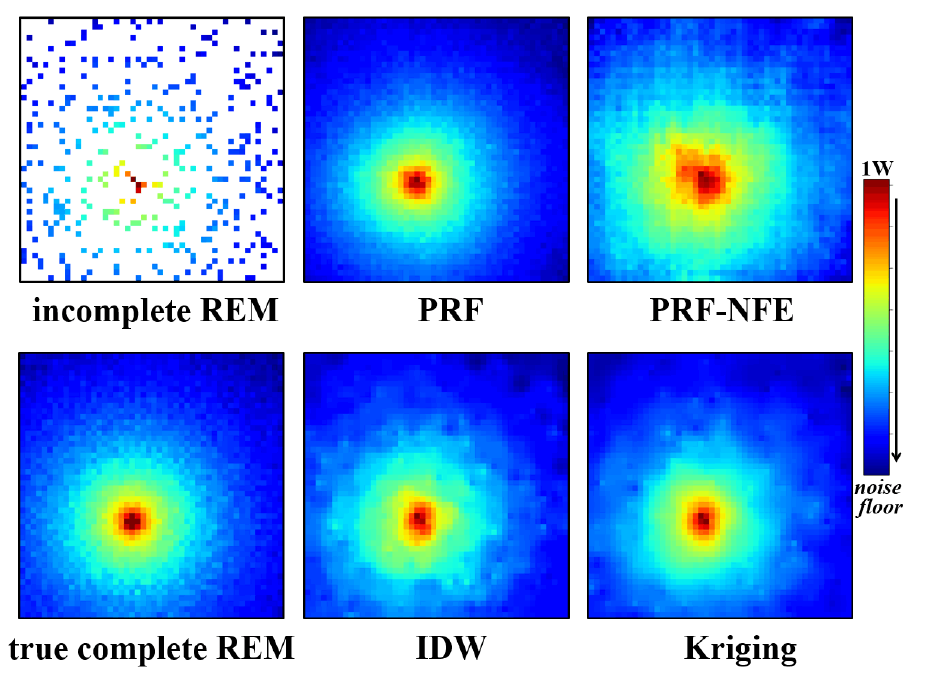
Figure 10. The incomplete radio environment maps, PRF, PRF without the feature enhancing module, IDW, Kriging with the exponential semi-variogram estimation results, and the true, complete radio environment map for PU1 at 25